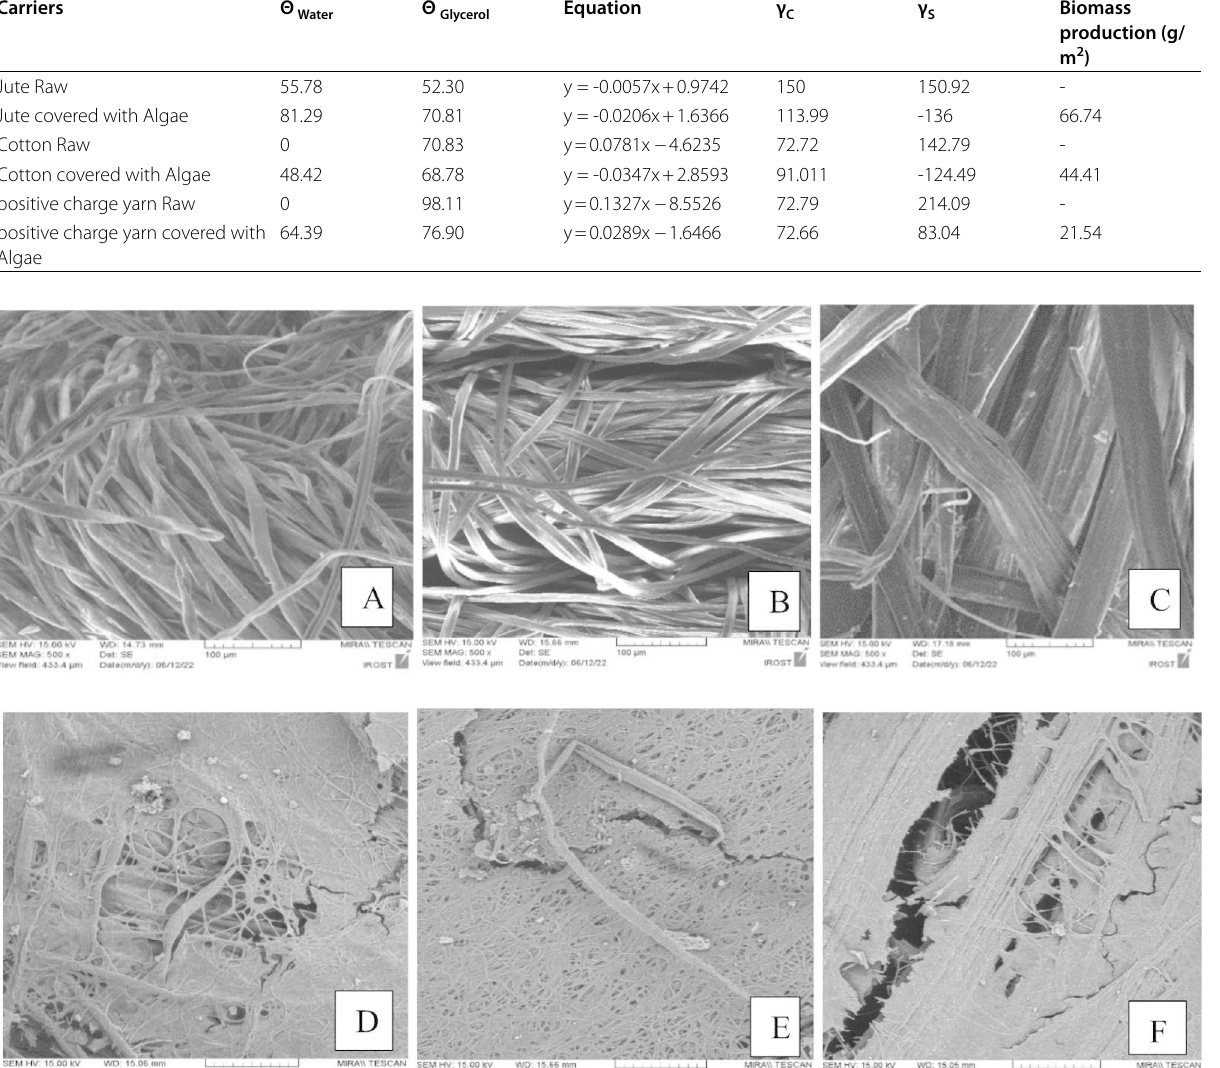
Table 1 Water contact angle, glycerol contact angle, critical surface free energy and surface free energy of the surface the jute, cotton and positive charge yarn such as water contact angle, glycerol contact angle, critical surface free energy and surface free energy as raw and coated with microalgae cell